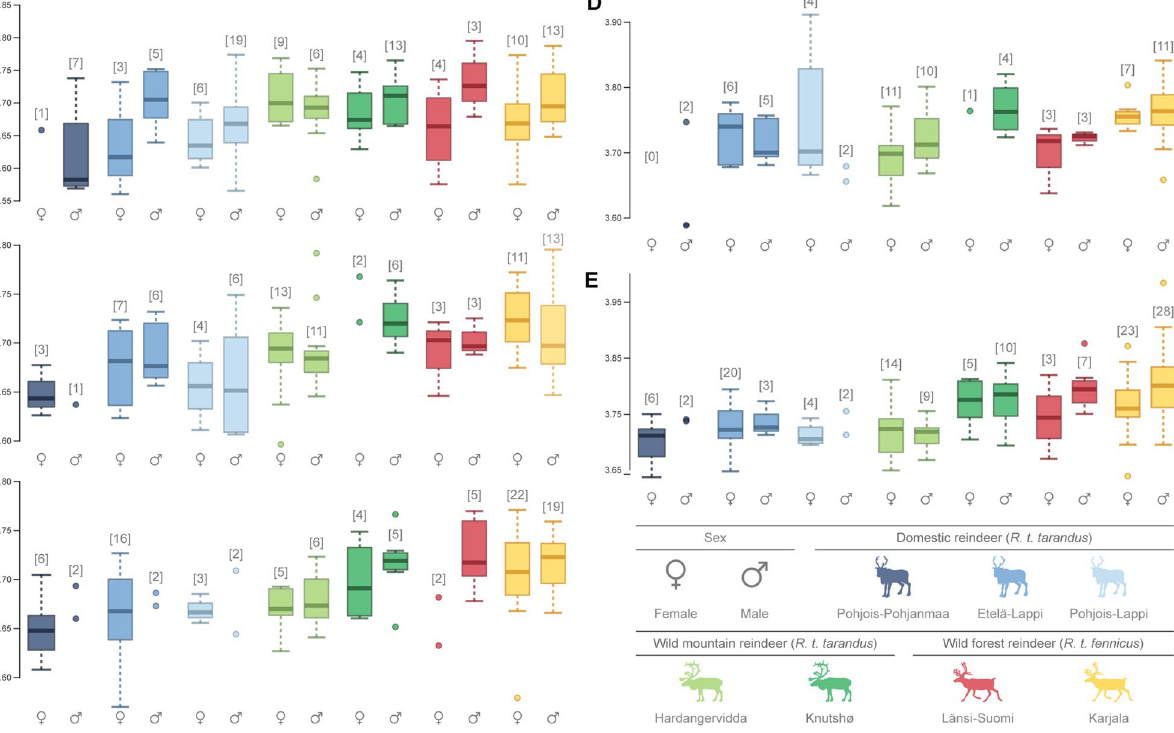
Figure 2. Boxplots of the variation in log-transformed centroid size (Csize) according to the population and sex for m1-Class1 ( A ), m1-Class2 ( B ), m1-Class3 ( C ), m2-Class1 ( D ) and m2-Class2 ( E ). The numbers in square brackets represent the number of teeth analysed in each